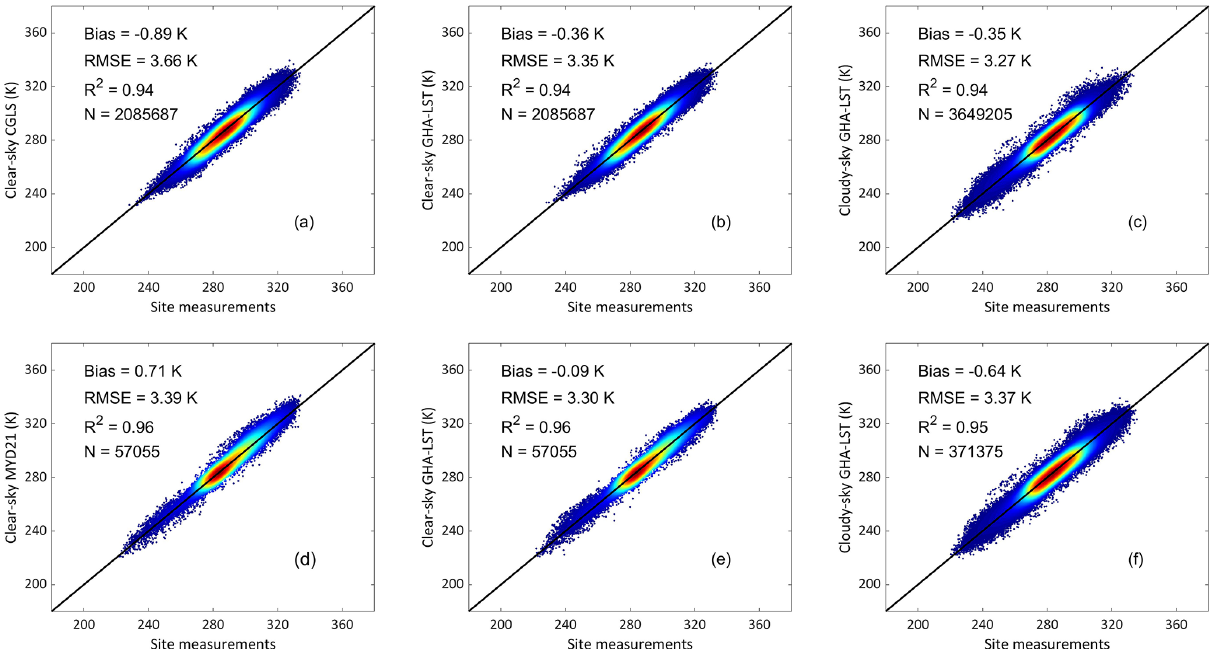
Figure 4. Density scatterplots of hourly LST samples from (a) CGLS clear-sky retrievals, (b) GHA-LST clear-sky samples corresponding to panel (a) , (c) GHA-LST cloudy-sky samples corresponding to CGLS cloudy time, (d) MYD21C1 clear-sky retrievals, (e) GHA-LST clear-sky samples corresponding to panel (d) , and (f) GHA-LST cloudy-sky samples corresponding to MYD21C1 cloudy time.